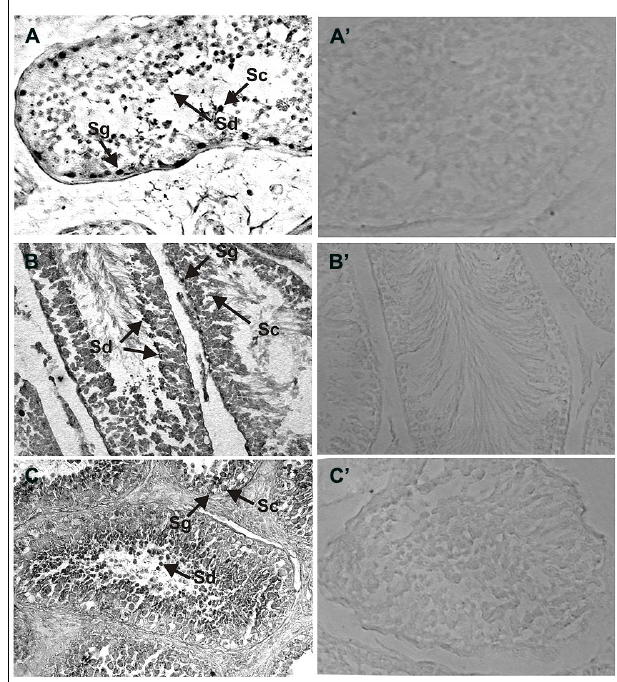
FIGURE 3 | Immunolocalization of NC δ in the testes. Paraffin sections of the testes were incubated with primary antibodies against NC δ . NC δ immunoreactivity was observed in all spermatogenic cells of human (A) , rat (B) , and bovine (C) testes. Particularly strong signal was detected in spermatocytes and spermatids localized close to lumen of the seminiferous tubule (indicated as Sc and Sd, respectively). Control staining was performed according to the procedure for NC δ detection, except that preimmune serum was used instead of the primary antibody (A’–C’) . Original magnification 400X.